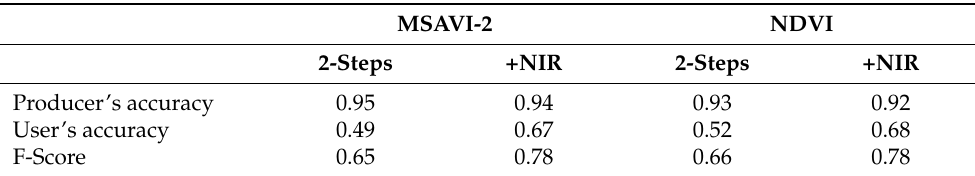
Table 5. Accuracy assessment and comparison of MSAVI-2 and NDVI, with and without third (NIR) cluster and masking step.